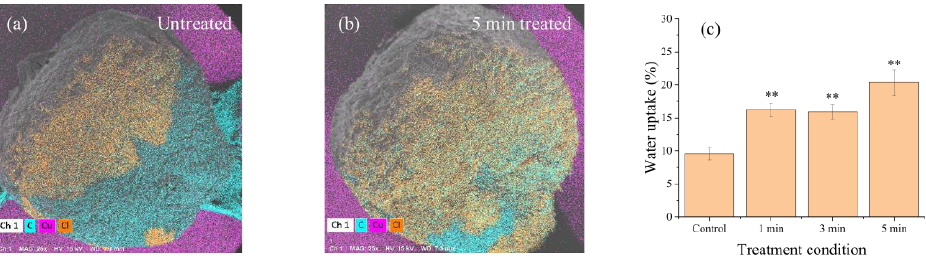
Figure 4. ( a ) EDS image of untreated spinach seed, ( b ) EDS image of spinach seed treated for 5 min, and ( c ) water uptake with RDBD treatment condition. The experiment was repeated three times with 150 seeds. (** denotes p < 0.01).